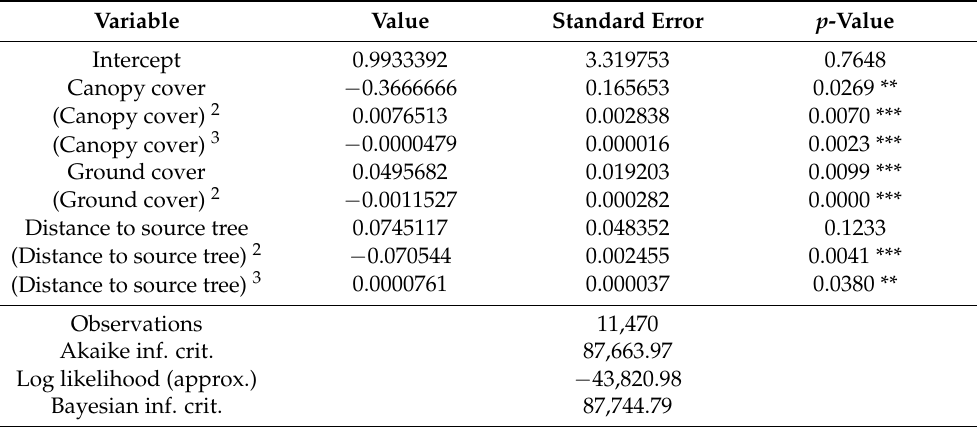
Table 3. Summary of model results, parameters. Note that the superscripts represent the 2nd and 3rd power. See also Equation (4) in the Section 2.